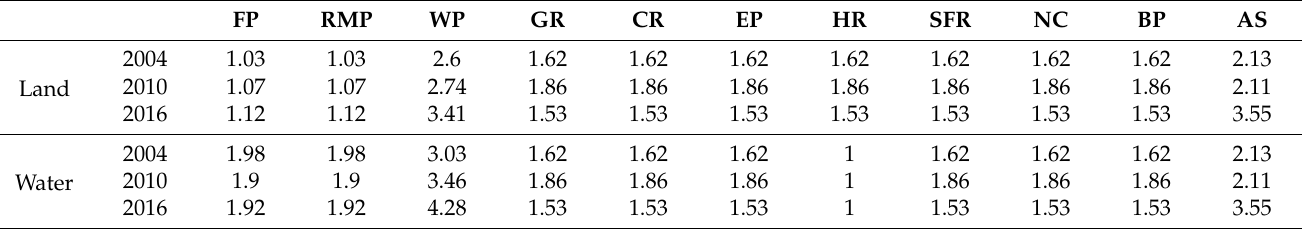
Table 3. The annual modified coefficients for ecosystem service